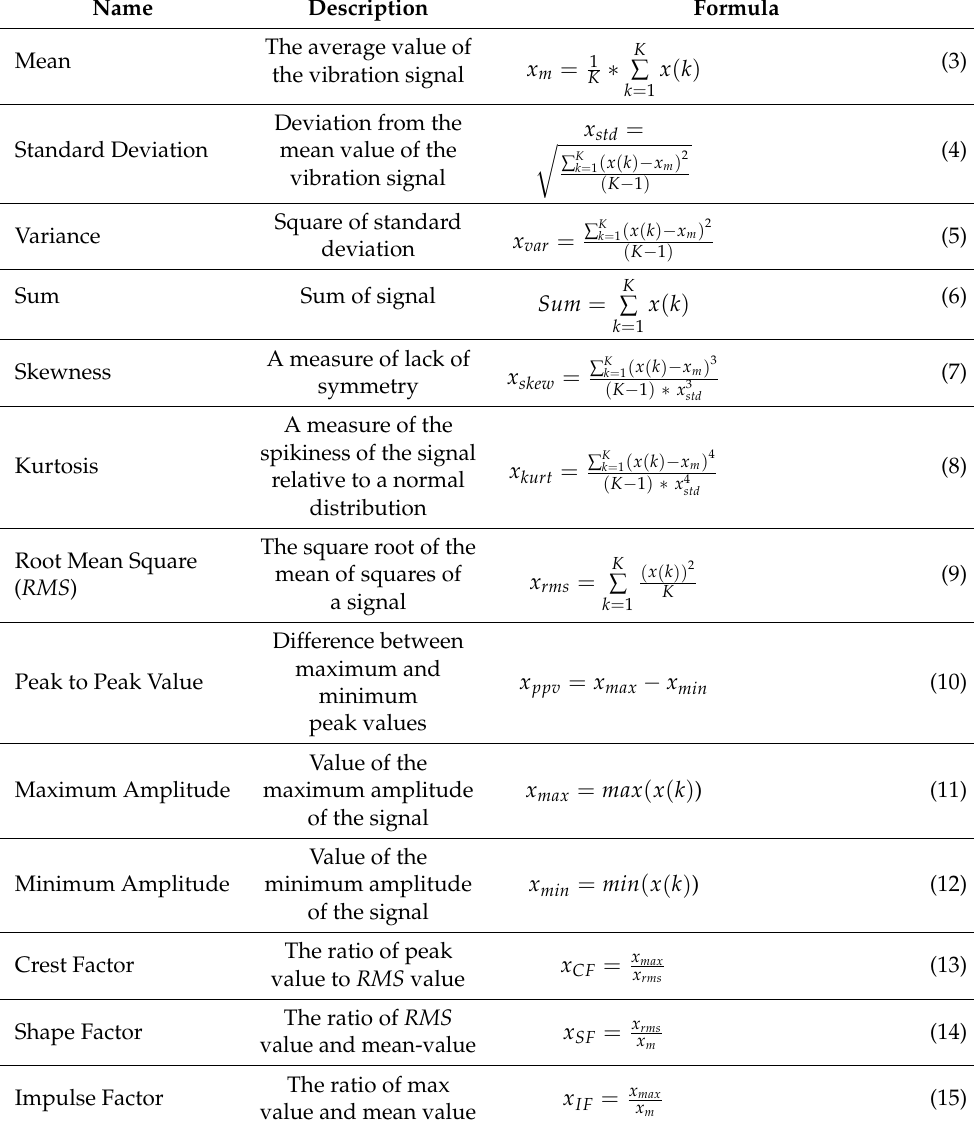
Table 2. Equations of Statistical Time-Domain